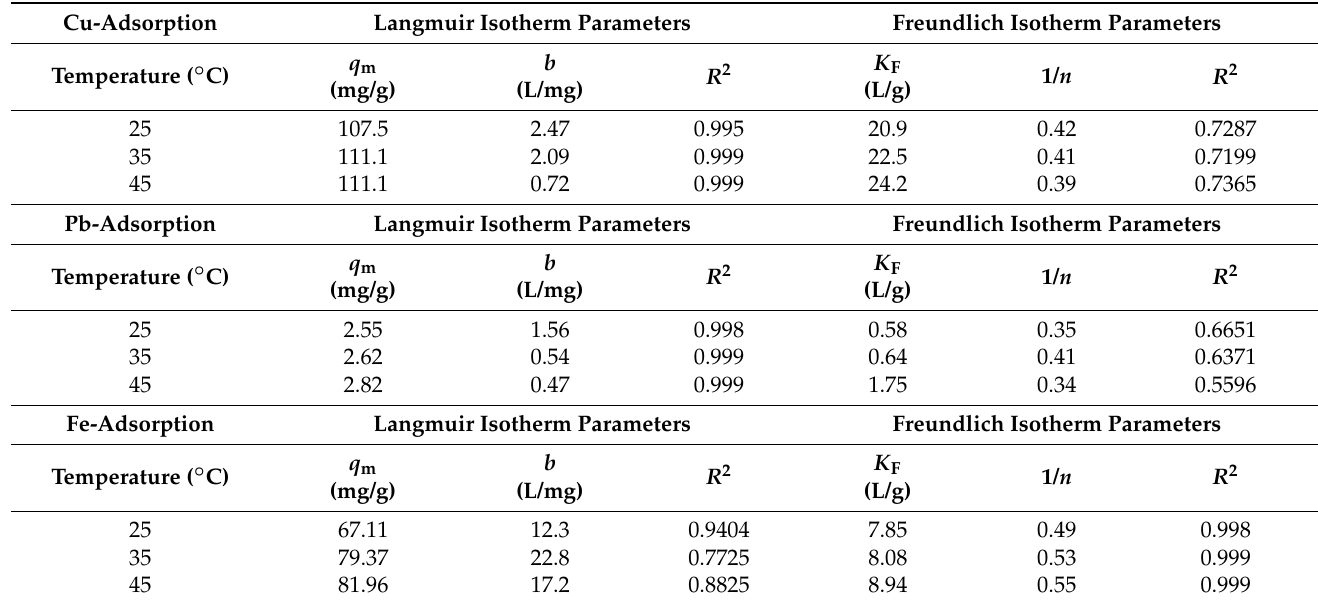
Table 2. Summary of isotherm parameters for Cu/Pb/Fe adsorption onto